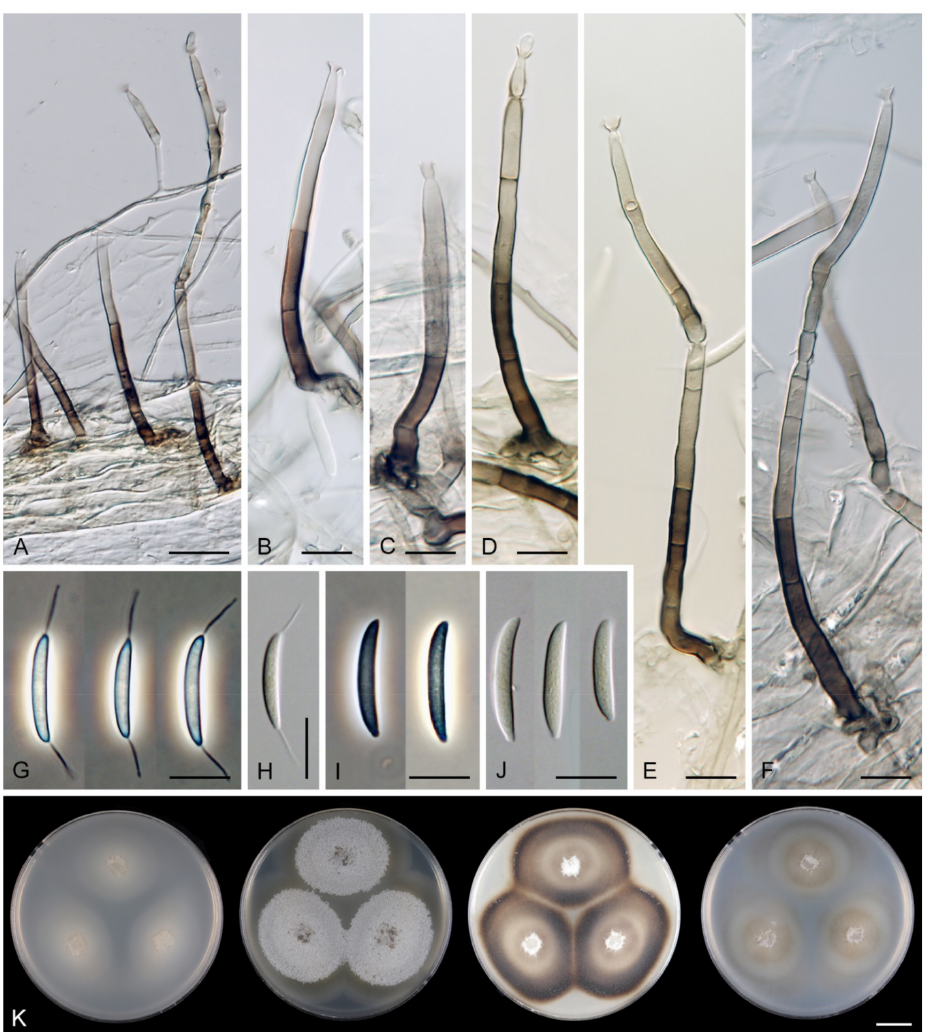
Figure 13. Tainosphaeria cecropiae . (CBS 101687 ex-type). ( A – F ) conidiophores ( G – J ) conidia ( K ) colonies on CMD, MLA, OA and PCA after 4 weeks (from left to right). Images: ( A – J ) on CMA with Urtica stems after 8 weeks. Scale bars: ( A ) 20 µ m; ( B – J ) 10 µ m; ( K ) 1 cm. Etymology: named after the host plant, Cecropia